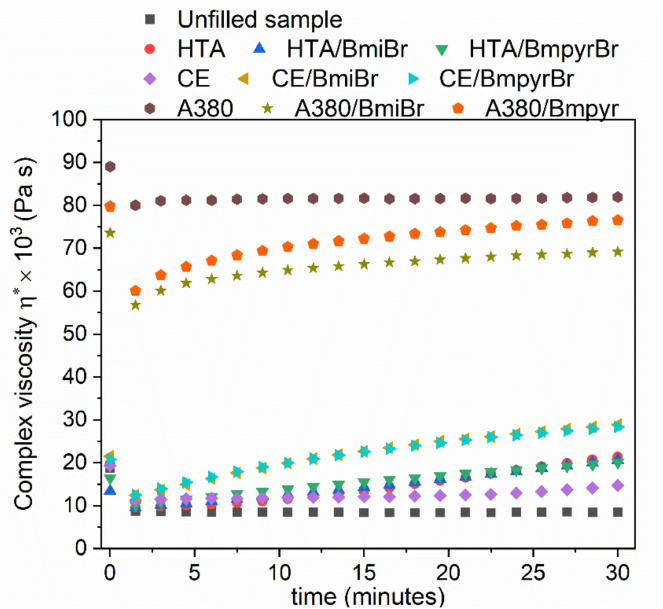
Figure 4. Effect of fillers and ILs on the complex dynamic viscosity ( η *) of NR compounds as function of time.